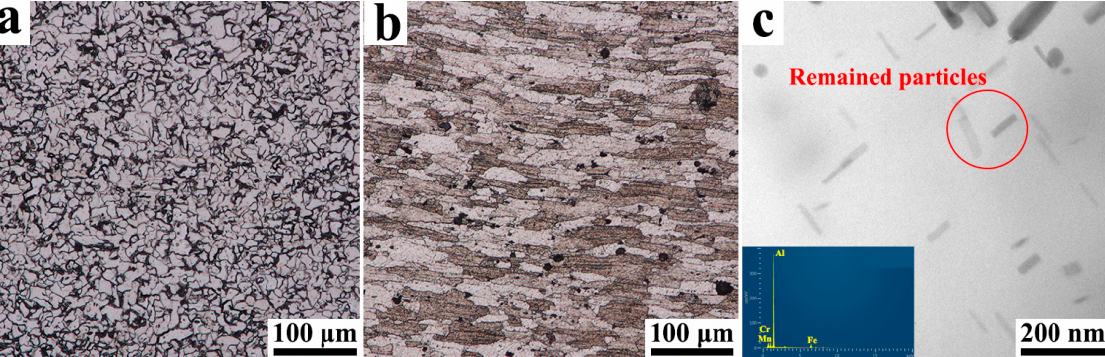
Figure 2. The grain morphologies in the BMs of ( a ) Q235 and ( b ) AA7075; ( c ) the remaining particles in the matrix of AA7075.